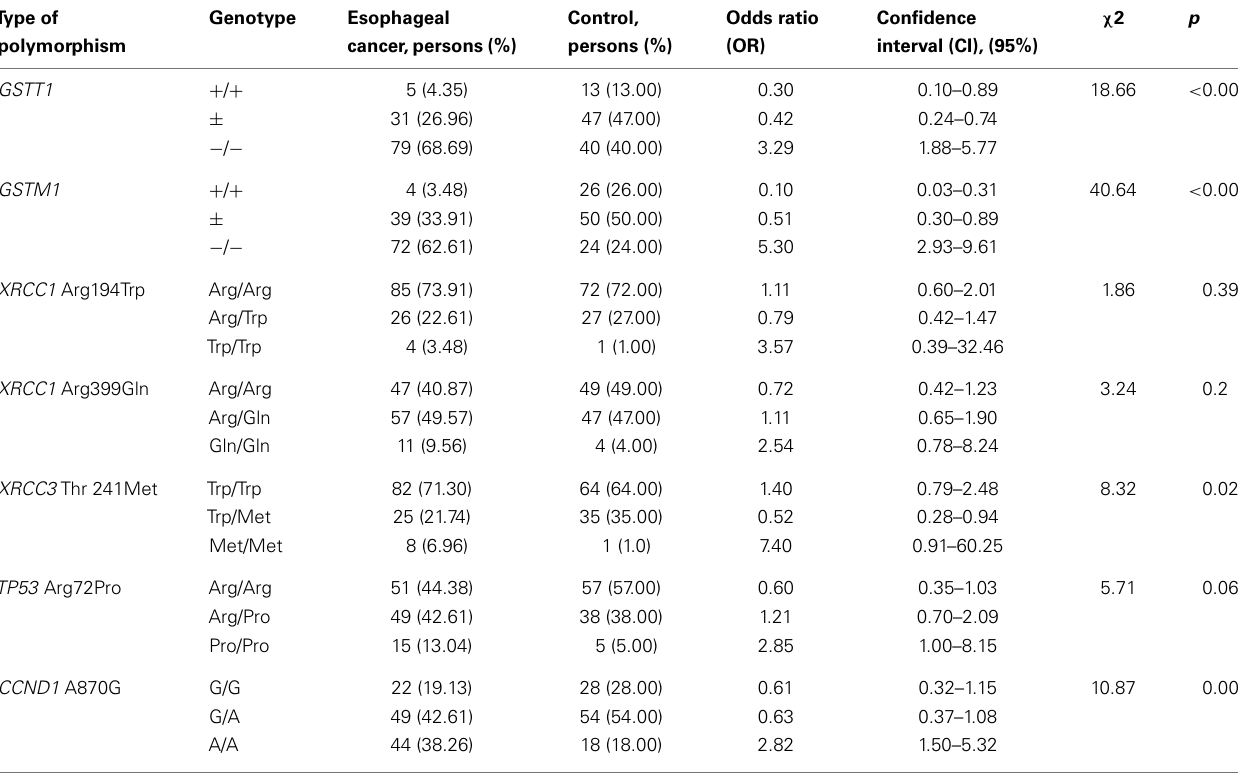
Table 4 |Association between genetic polymorphism and development of esophageal cancer.